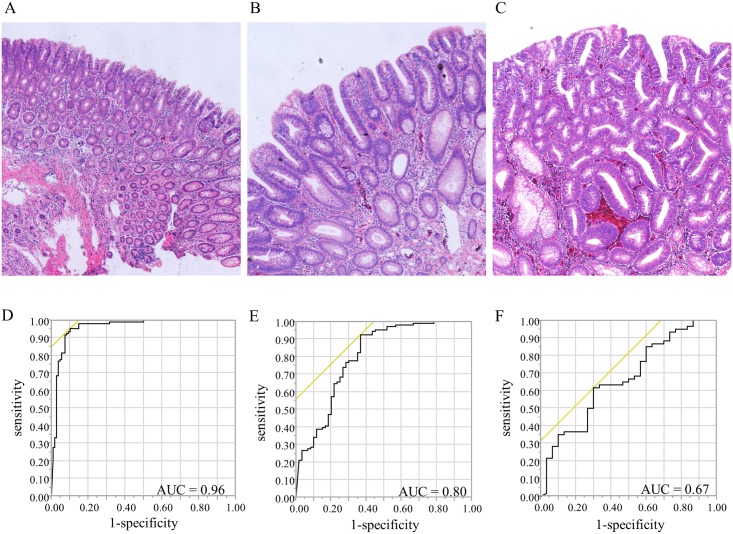
Standard light microscopy findings on hematoxylin-eosin-stained specimens of colorectal adenoma (40×, magnification) and ROC curves for distinguishing between the two tissues.A: mild atypia. B: moderate atypia. C: severe atypia. D: ROC curve of CDO1 promoter methylation for distinguishing between cancer tissue and NAM. When the cut-off value was 15.6, the AUC was 0.96, sensitivity was 95%, and specificity was 90%. E: ROC curve for distinguishing between low-grade adenoma and NAM. F: ROC curve for distinguishing between low-grade adenoma and high-grade adenoma.